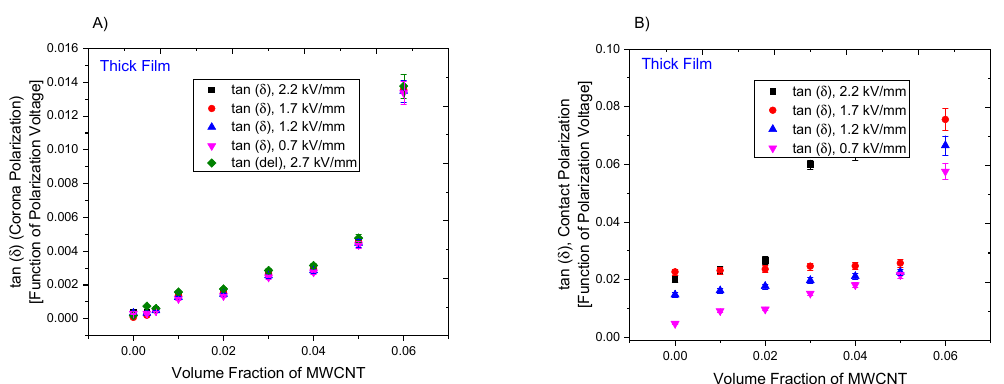
Figure 9. Dielectric loss, tan δ , of thick films as a function of polarization voltage and volume fraction of MWCNTs for ( A ) corona and ( B ) contact polarization conditions.